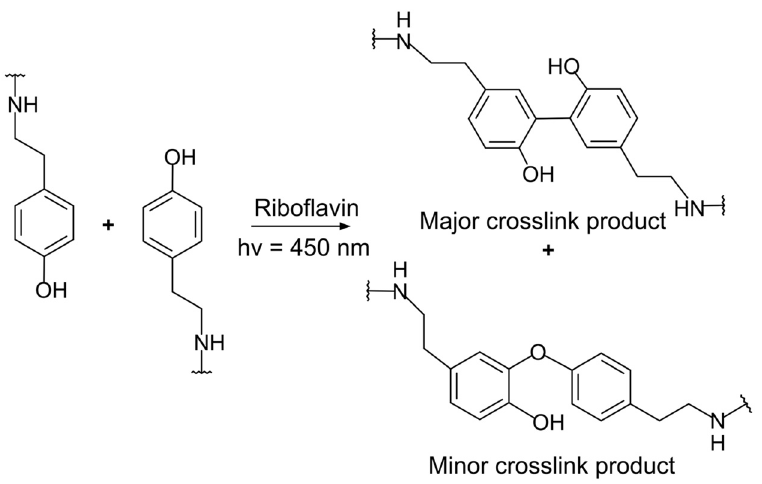
Figure 5. Schematic of the dityramine formation via the RF-mediated photoreaction from tyramine groups.